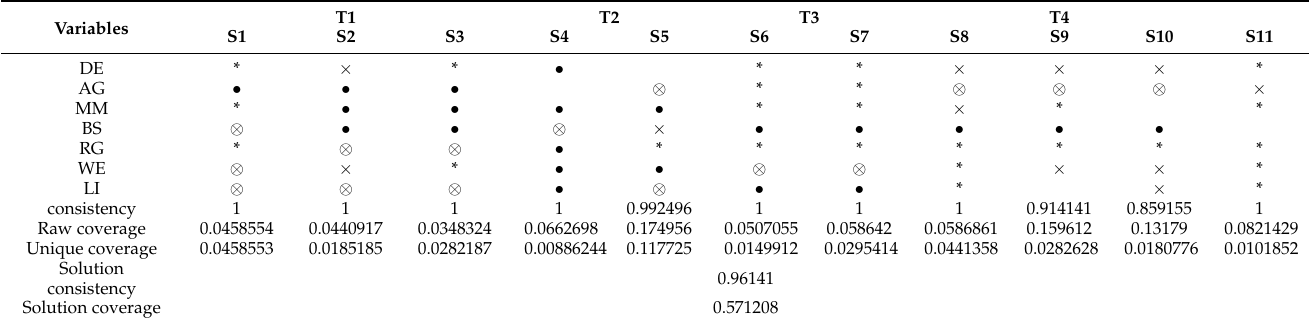
Table 5. Conditional configuration analysis of road transportation safety